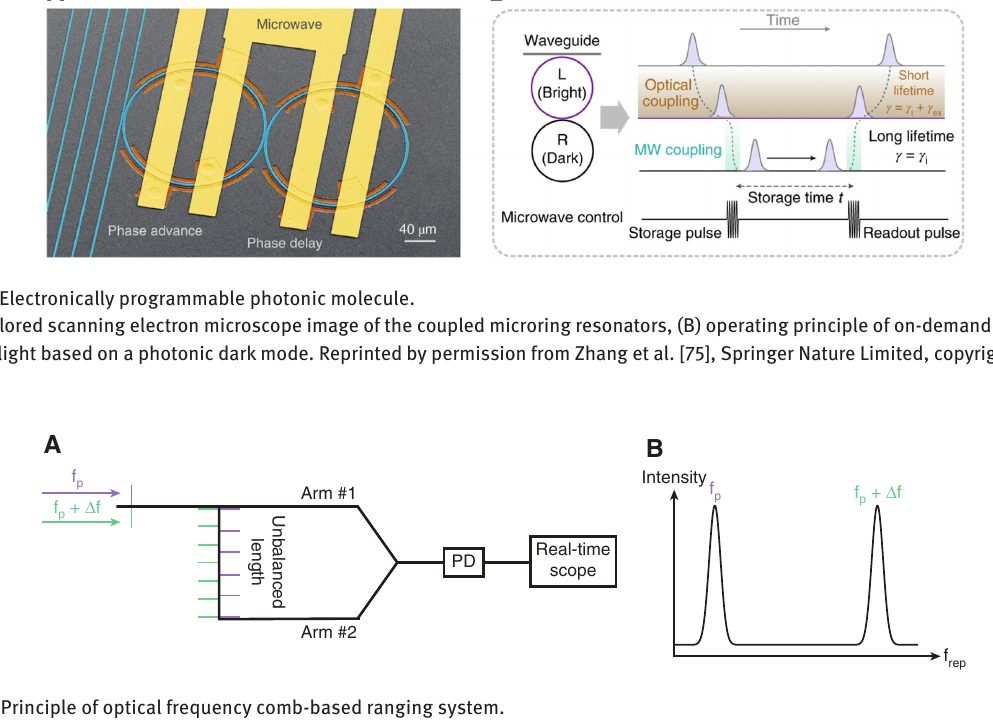
Figure 26: Principle of optical frequency comb-based ranging system. (A) Two pulse trains come from a repetition rate adjustable optical frequency comb. Constructive temporal interference happens when the unbalanced length (including the distance under test and the length of delay fiber) corresponds to an integer number of pulses. (B) So, by sweeping the repetition rate, constructive interference happens at different repetition rate according to the distance under test. Once the two peaks are found by changing the repetition rate, the distance is measured. A larger repetition-rate sweeping range leads to a larger range of measurable distance. A fast sweeping speed of repetition rate enables measuring the speed of a fast-moving object. PD, photodiode. See Kayes and Rochette [205] and Yang et al. [206] for